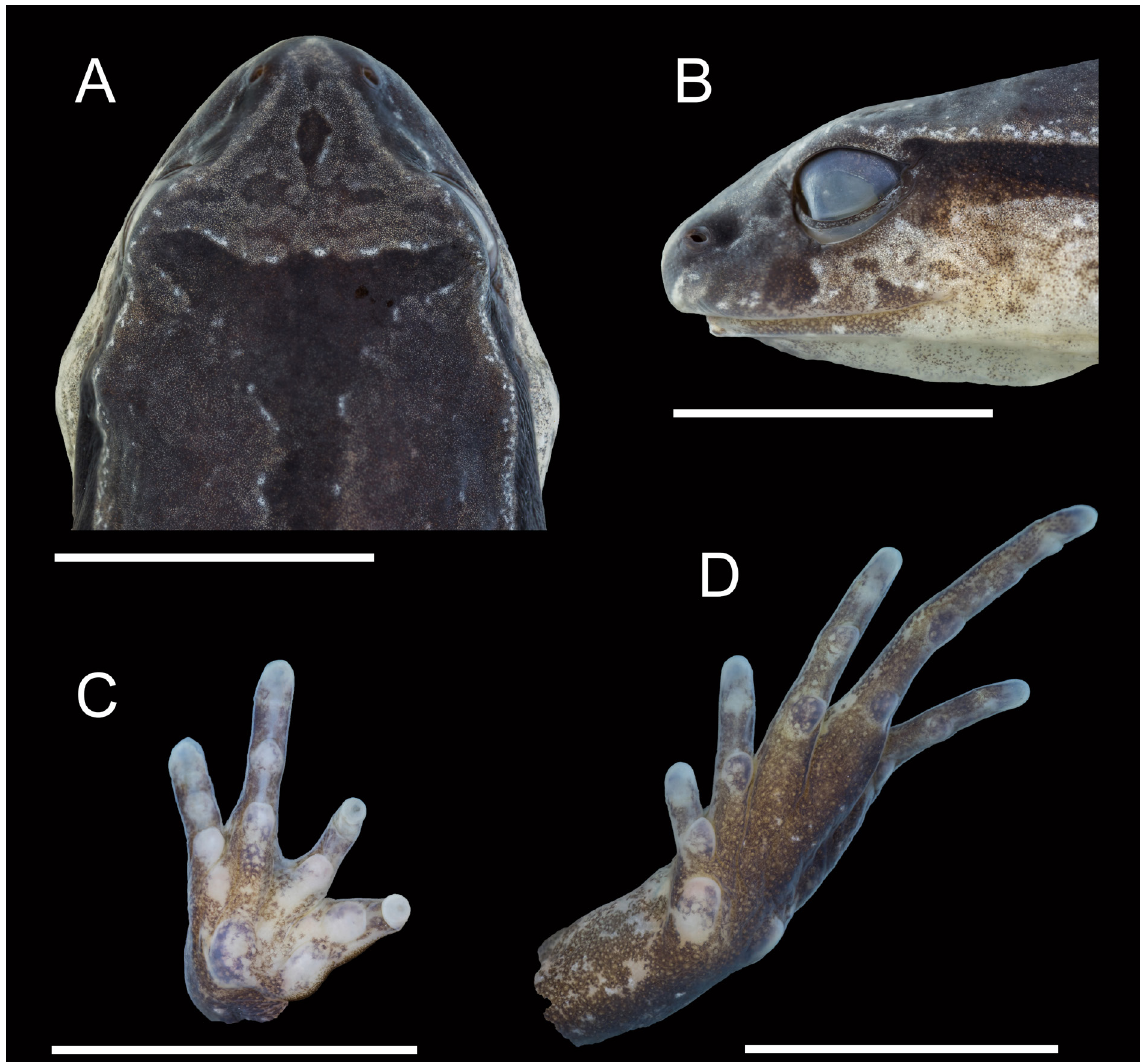
Fig. 2. Physalaemus araxa sp. nov., holotype, adult ♂ (ZUEC-AMP 24095). A . Head, dorsal view. B . Head, lateral view. C . Right hand, ventral view. D . Right foot, ventral view. Scale bars = 2